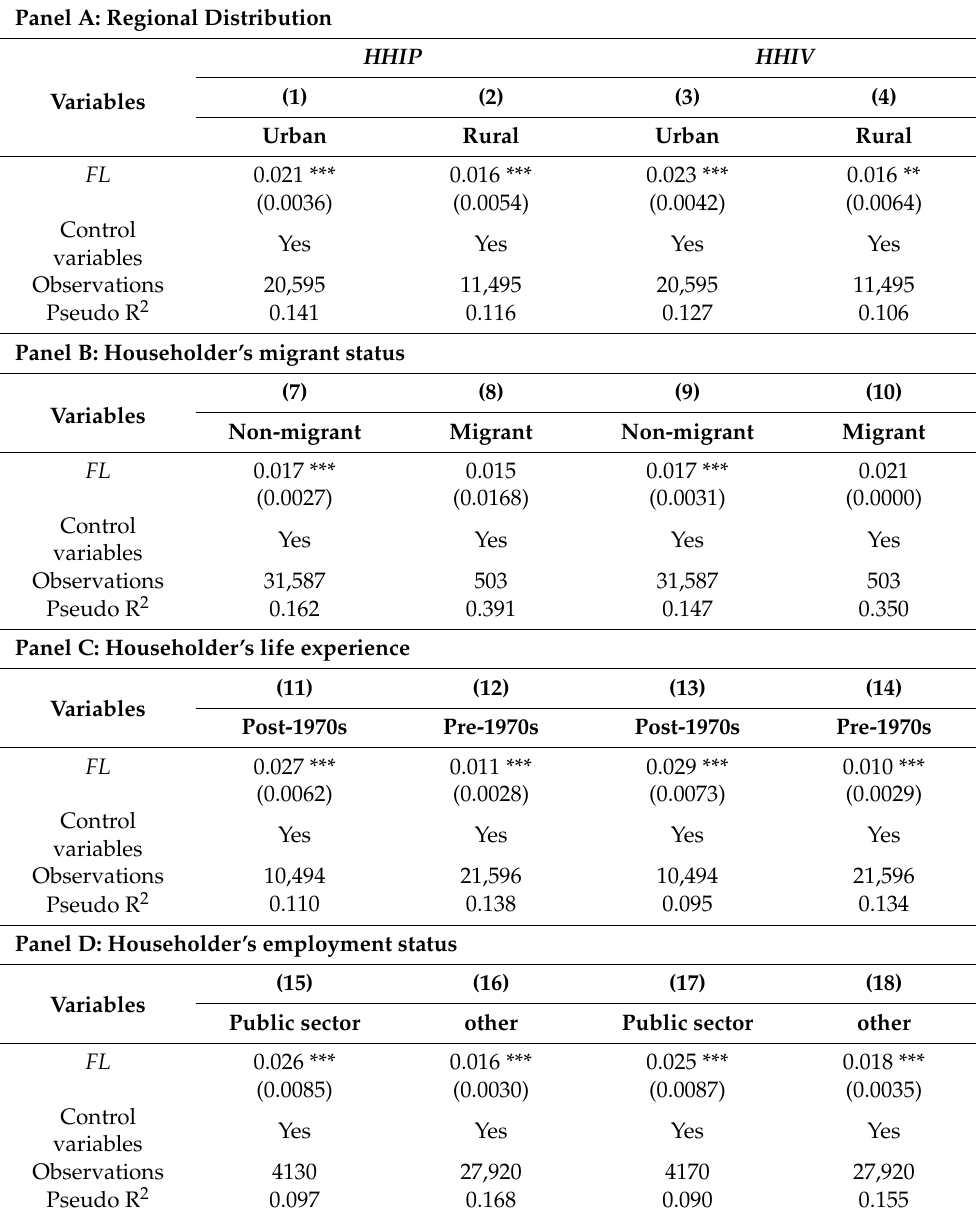
Table 7. Heterogeneity